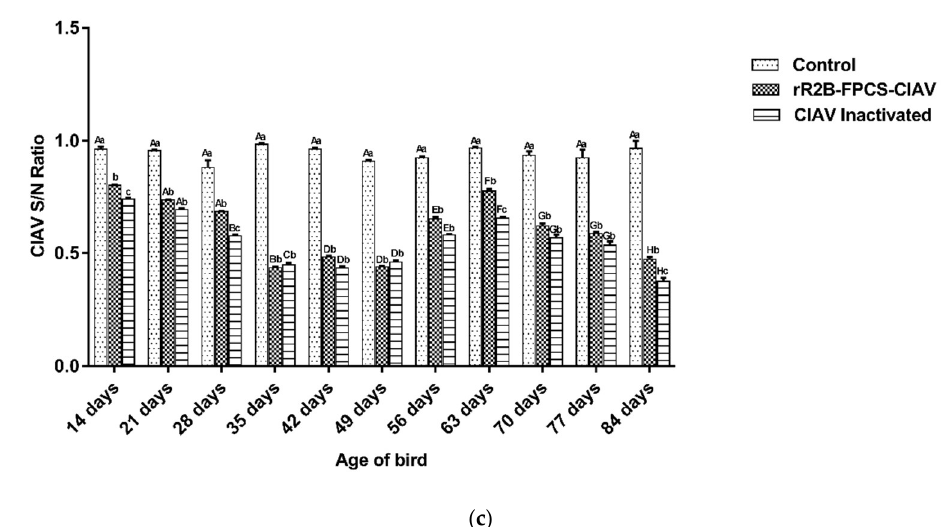
Figure 5. NDV and CIAV specific serum antibody response in the experimental chicken. ( a ) At seven days of age, the birds from three groups were immunised with rR2B-FPCS-CIAV, rR2B-FPCS and LaSota as a primary vaccine. The control group was injected with phosphate buffered saline (PBS). The booster dose was given at 28 and 56 days of age, respectively. At weekly intervals, blood sera were collected from the immunised and control group of birds for testing NDV-specific antibodies by ELISA. The antibody titres higher than 200 were considered positive; ( b ) determination of NDV- specific antibody titre by HI. ELISA and HI were performed at 14, 21, 28, 35, 42, 49, 56, 63, 70, 77 and 84 days of age from all birds. All HI titres were expressed as mean reciprocal of log2 titre ± SEM (standard error of the mean) ( n = 10); ( c ) one group of birds was vaccinated with CIAV-inactivated vaccine at 7 days of age as a primary vaccine and 28 and 56 days of age as booster dose, respectively. Blood sera collected from the immunised and control group of birds at same intervals were tested for anti-CIAV antibody. The presence of antibody to CIAV was determined by sample to negative (S/N) ratio < 0.6 for each sample. Bars (mean ± SE) indicate the representative data of a single experiment. Data with different capital letter superscripts indicate time effect ( p < 0.0001) and small letter superscripts indicate the treatment effect ( p <